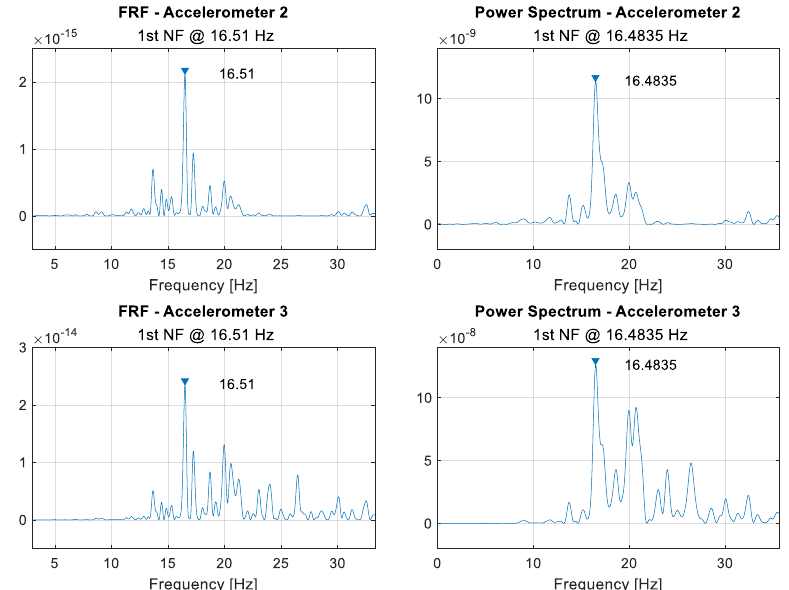
Figure A15. Arduino measurement: 6.0 revolution bolt release.